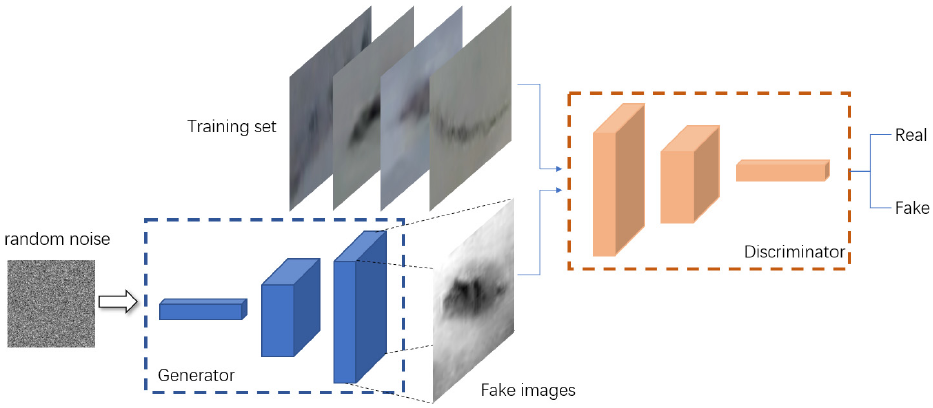
Figure 1. The process of scratch sample generation by